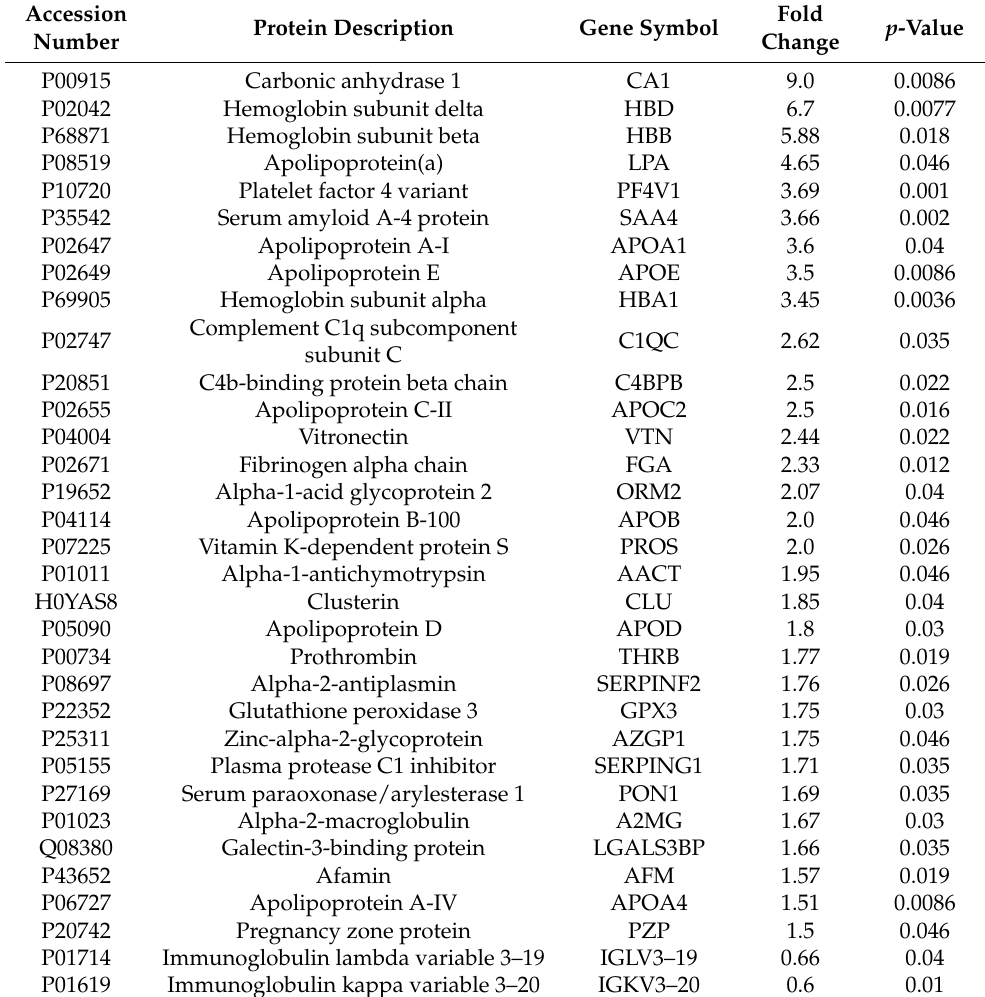
Table 1. Different abundance proteins identified by mass spectrometry in EC compared to the control serum exosome.